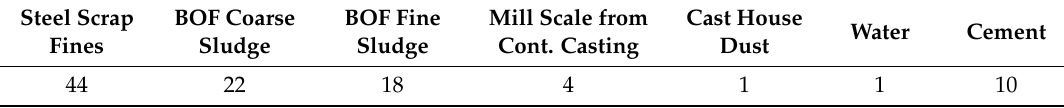
Table 5. Recipe used for the briquettes used in the full-scale trials in the steel shop (wt.%). Steel Scrap BOF Coarse BOF Fine Mill Scale from Cast House Water Cement Fines Sludge Sludge Cont. Casting Dust 44 22 18 4 1 1